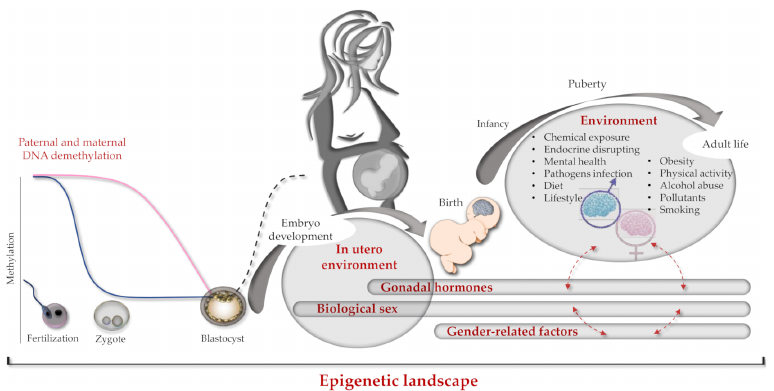
Figure 2. Brain epigenome imprinting. Schematic representation of genetics and epigenetics in- teractions occurring from conception to individual adult life. On the left, paternal and maternal hemigenome DNA demethylation processes occurring during fertilization (blue and pink lines re- spectively). In the middle, de novo global genome methylation at the blastocyst phase is shown as a dark dashed line. On the right, dashed red arrows indicate cross-interactions between different epigenetics factors (e.g., sex and